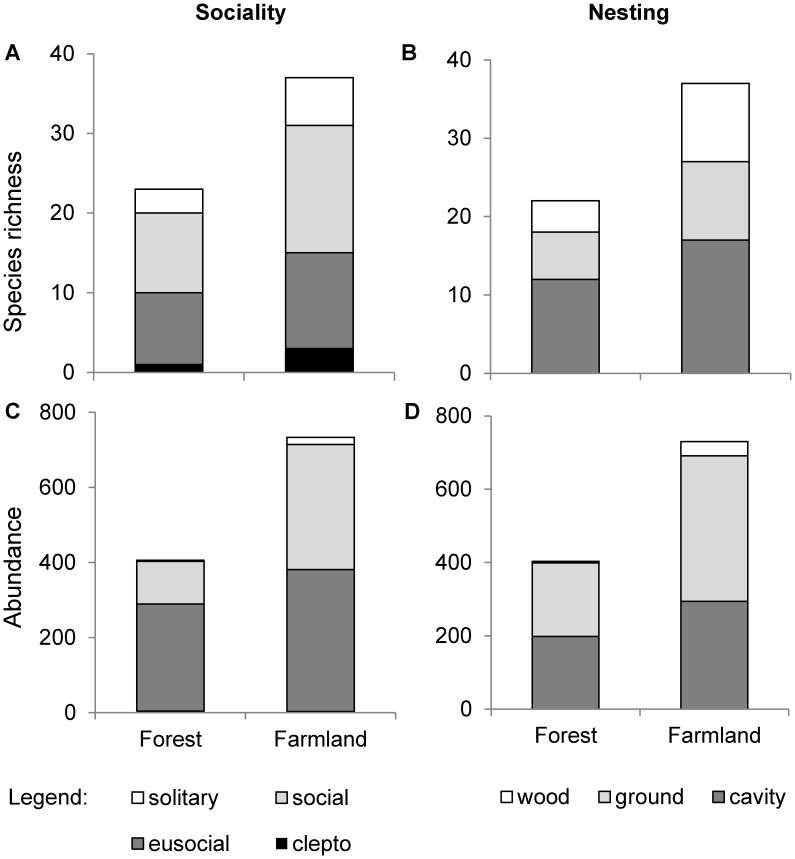
Degree of sociality and nesting requirements
in bees. Differences in (A, B) species richness and (C, D) abundance of bees between protected forest and heterogeneous farmland (pooled data over 3 months and 15 study sites). Bees are separated into four degrees of sociality (solitary, social, eusocial, and cleptoparasitic) and three groups of nesting requirements (wood-nesting, ground-nesting, cavity nesting). For assignment of bees see Table S1.